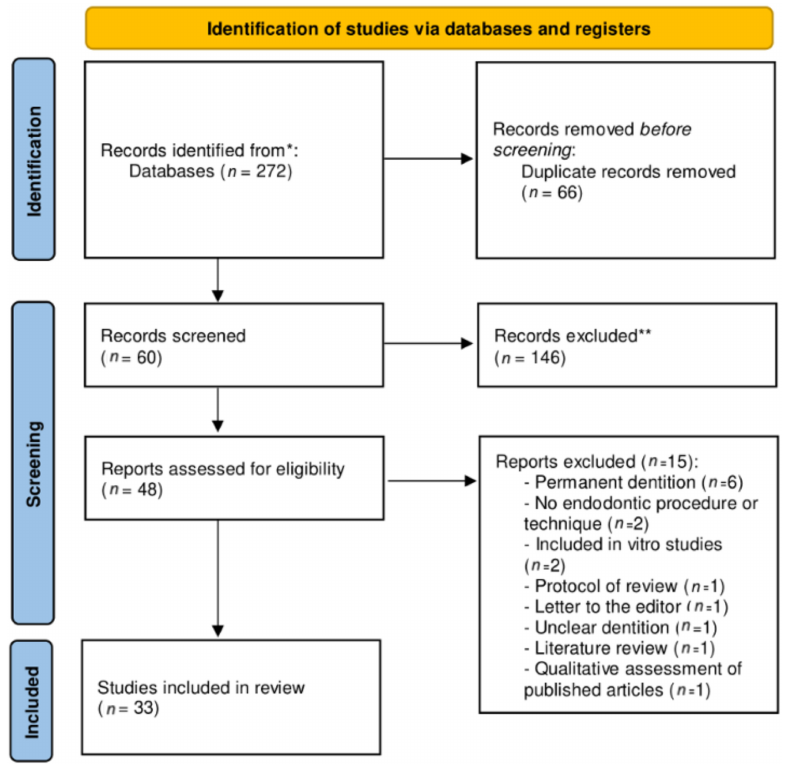
Figure 1. PRISMA flowchart of included